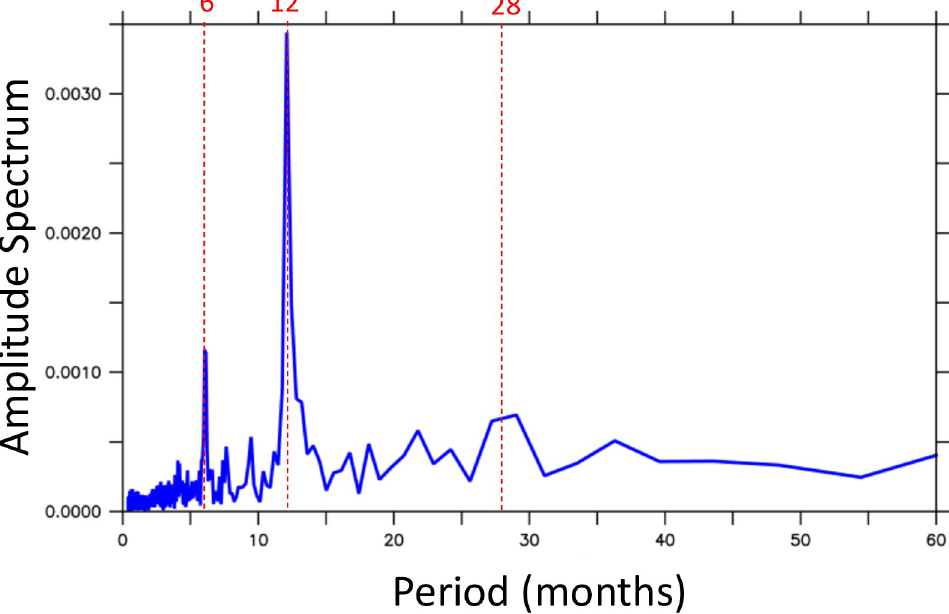
Fig 12. Amplitude spectrum of the time-series of the total freshwater exchange by the baroclinic circulation across the Strait of Hormuz ( M + M ). ov az